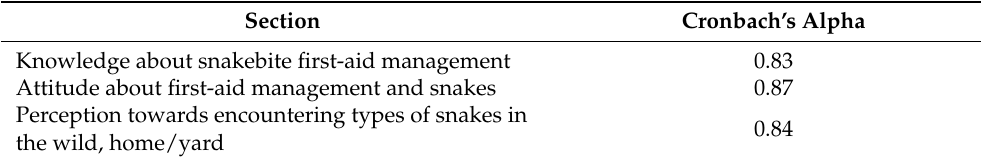
Table 1. Reliability